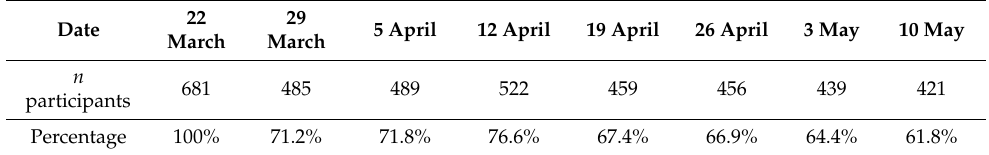
Table 1. Participation during lockdown.